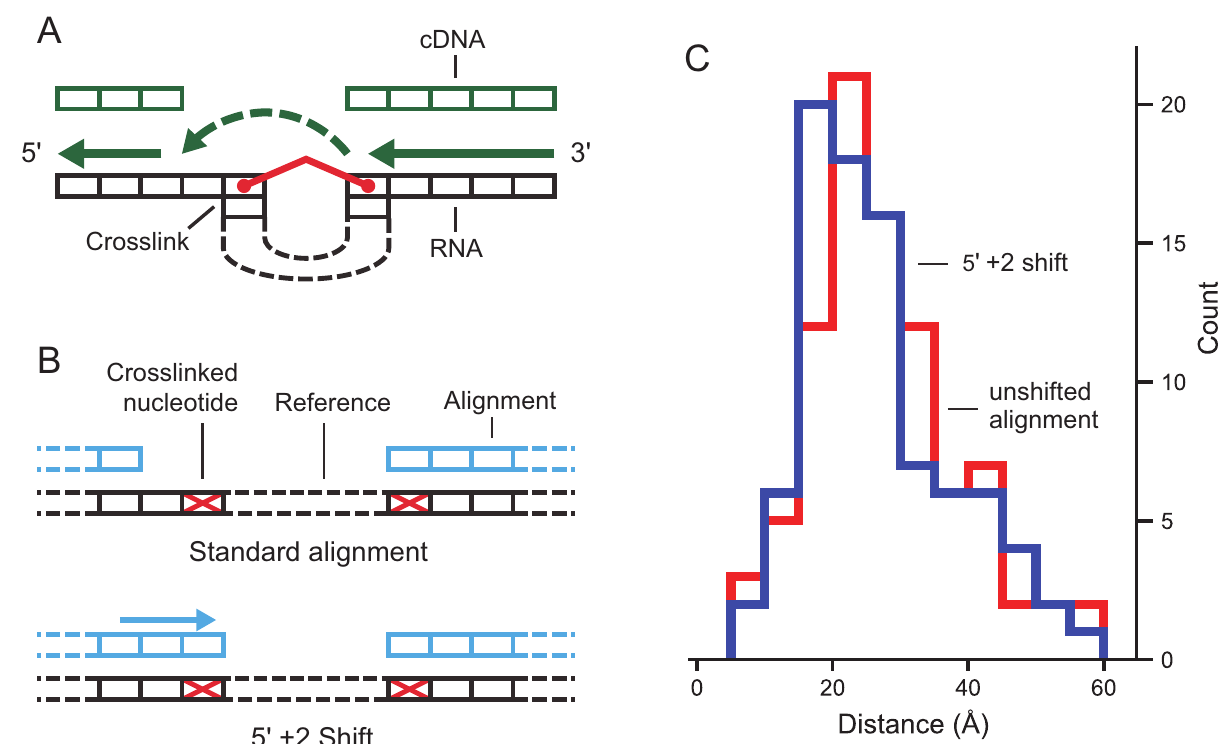
Fig 5. Effect of shifting deletion site assignment on through-space distance. ( A ) Relationship between crosslinked RNA and RT jumping. Directionality of reverse transcription and crosslink-induced steric hindrance can yield an offset at the 5’ deletion site relative to crosslink position. ( B ) Deletion site adjustment to compensate for the mechanism of RT jumping. ( C ) Distance distribution of RNase P RNA SHAPE-JuMP data for unshifted (red) and shifted (blue) deletion assignments. Through-space distances are shown for the deletions corresponding to the most frequent 3% of deletions. Datasets were processed using the fully optimized ShapeJumper pipeline with the exception of the shift or not for the RT landing mechanism.